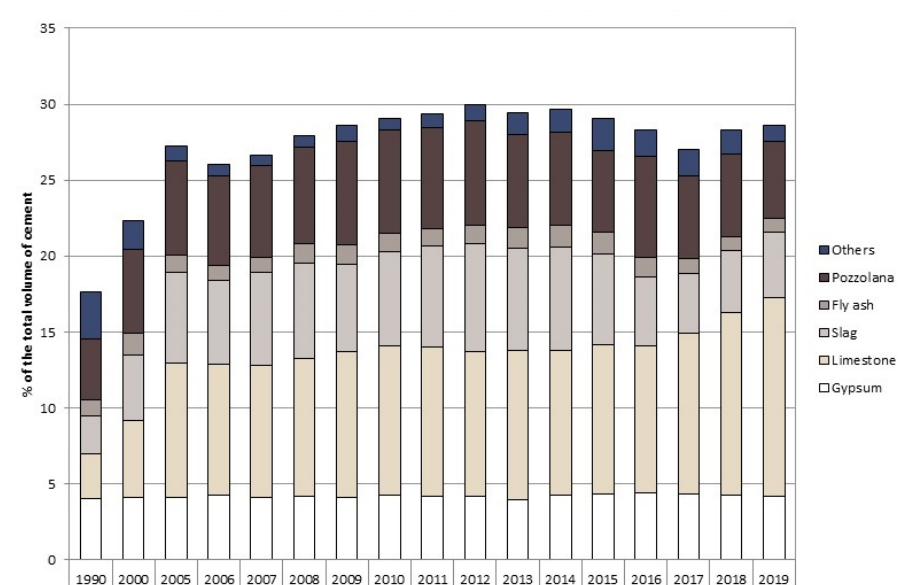
Figure 3. Mineral components used to produce clinker ‐ based Portland cement in LAC (GNR data – GCCA [13], estimated LAC coverage: 71% in 2010, 74% in 2018, 74% in